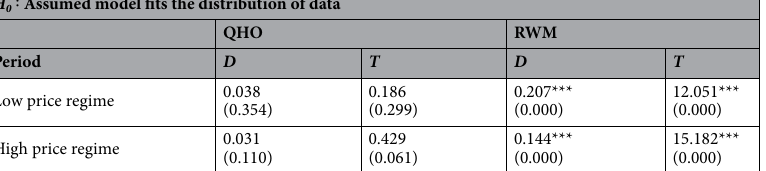
H 0 ∶ Assumed model fits the distribution of